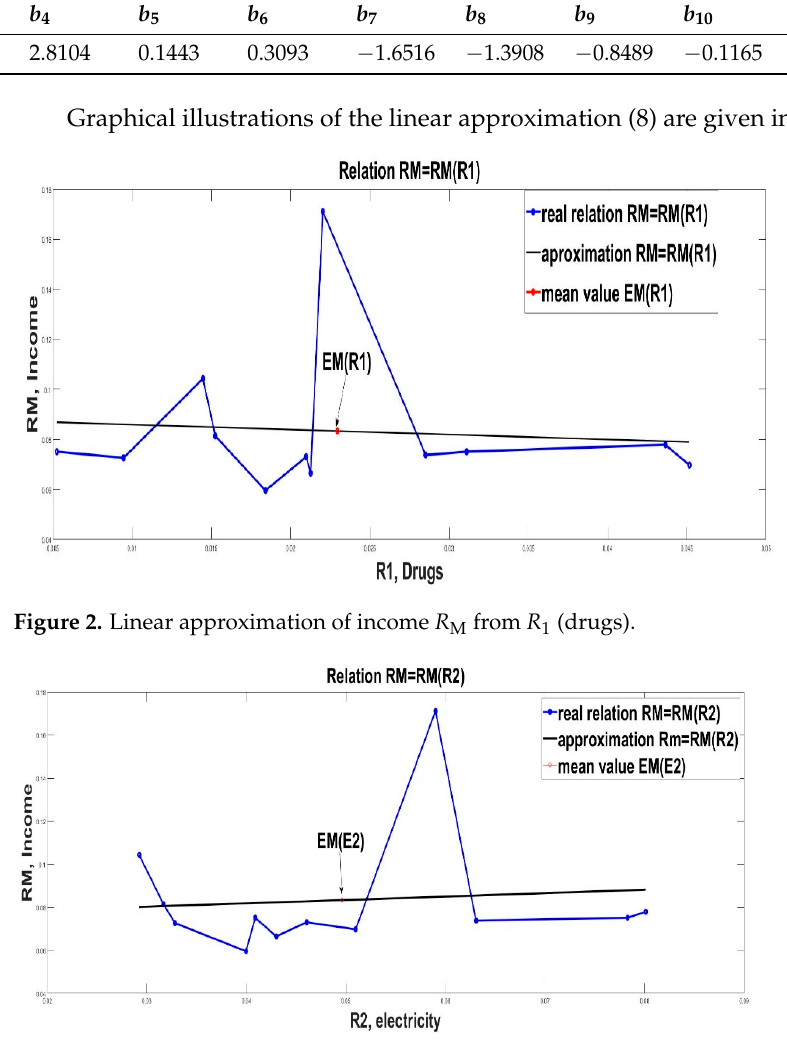
Figure 3. Linear approximation of income R M from R 1 (electricity).